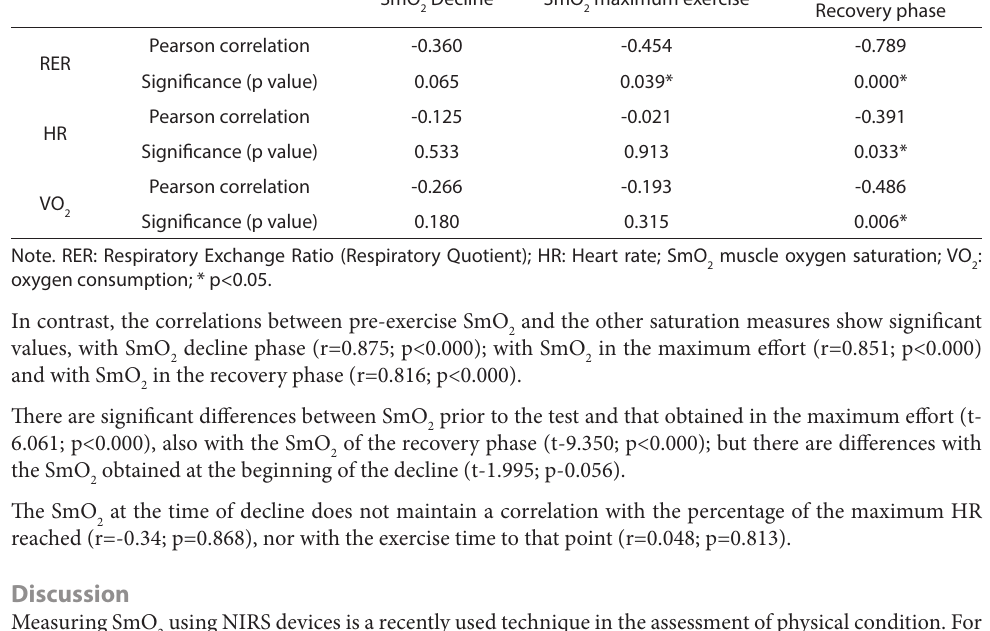
and ergometry 2